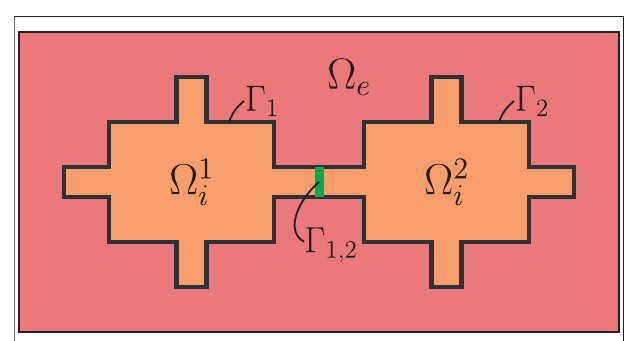
FIGURE 6 | Two-dimensional illustration of the EMI model domain for two connected cells. The domain consists of two cells, Ω 1 i and Ω 2 i , with cell membranes denoted by Γ 1 and Γ 2 , respectively. The cells are connected to each other by the intercalated disc, Γ 1,2 , and surrounded by an extracellular space, denoted by Ω e . The fi gure is reused from Ref. 48 with permission from the publisher.